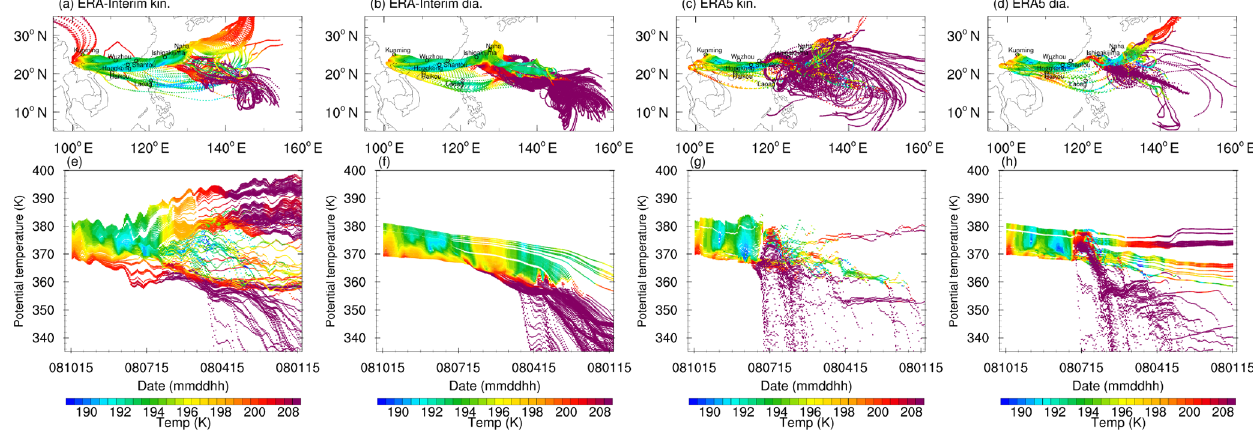
Figure 12. As Fig. 5 but for the case on 10 August 2015.